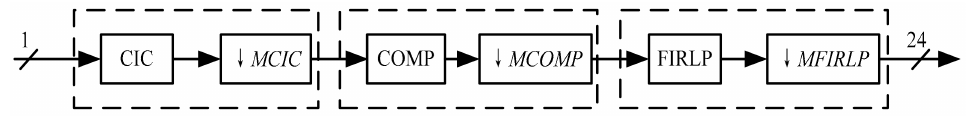
Figure 9. Cascade structure of digital